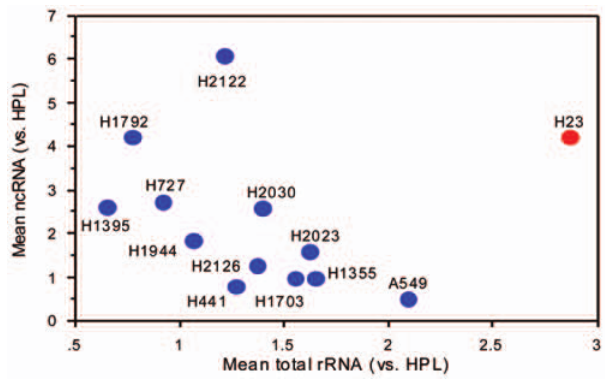
Figure 4. Correlation of averages levels of total 45S rRNA (relative to HPL cells) with average levels of nc-rRNA (relative to HPL cells) in human lung cancer lines. When outlier line H23 was omitted, the Spearman rank correlation coefficient rho= 2 0.74, P=0.0135 by the Spearman rank test.